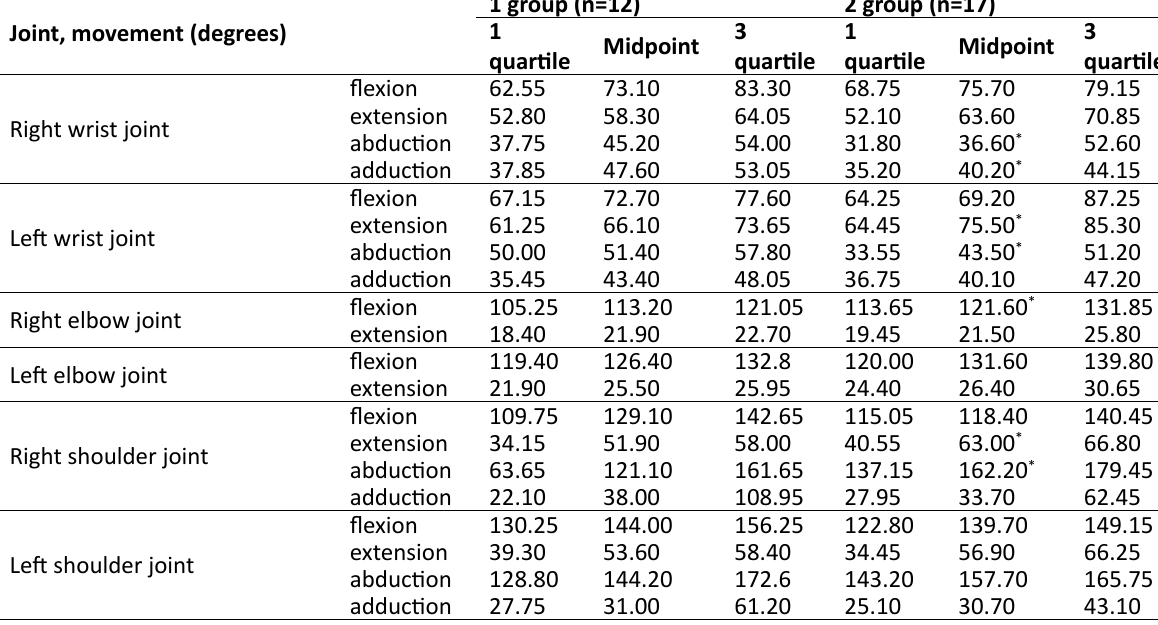
Table 2. Goniometric indicators of single combats athletes Joint, movement